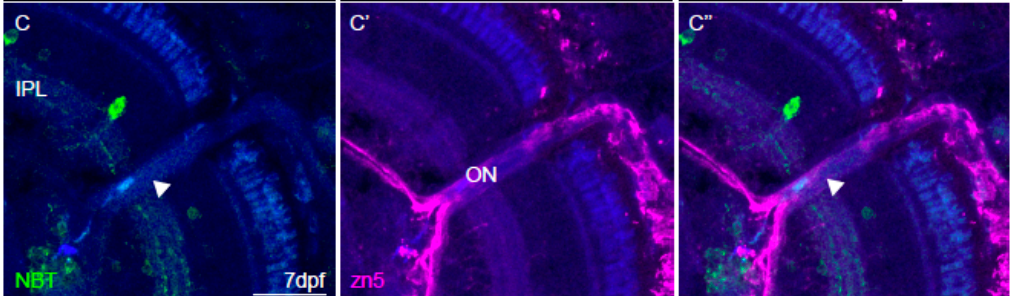
Figure 2. Characterisation of NBT :GCaMP3 expression in the eye of 7 dpf fish. ( A ) The NBT:GCaMP3 transgene product, visualised with an anti-GFP antibody (green), sparsely labels HuC/D positive neurons (magenta) that project to the synaptic inner plexiform layer (IPL). Amacrine cells are labelled in the inner nuclear layer (arrows) and retinal ganglion cells are labelled in the ganglion cell layer (arrowheads). ( B ) Anti-GFP antibodies label only a small number of zn5-positive retinal ganglion cells (arrowhead). GFP-positive amacrine cells in the inner nuclear layer are zn5-negative (arrow). ( C ) The NBT:GCaMP3 transgene is expressed in a small number of retinal ganglion cell axons in the optic nerve (ON, arrowhead). The blue label is a counterstain. Scale bars in A = 40 µm, B = 50 µm, C = 25 µm.